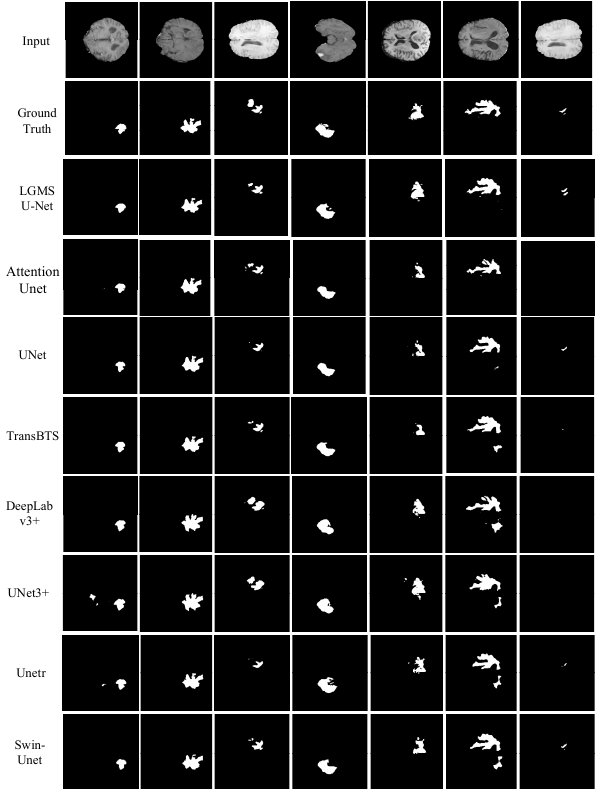
Figure 5. BTS results of seven state-of-the-art methods versus the proposed LGMSU-Net. The first row represented the visual image of the input image, the second row represented the ground-truth image of the brain tumor, and the third row represented the segmented brain tumor image through our proposed model, the remaining seven rows were the segmented images of the other seven ad- vanced brain tumor segmentation models in Table 4.